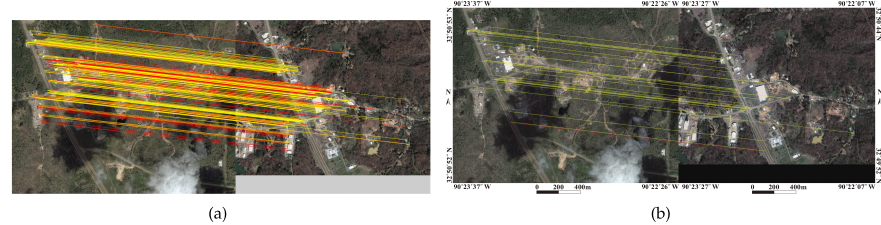
Figure 14. Matching results of image pair 6. ( a ) LJL; ( b )